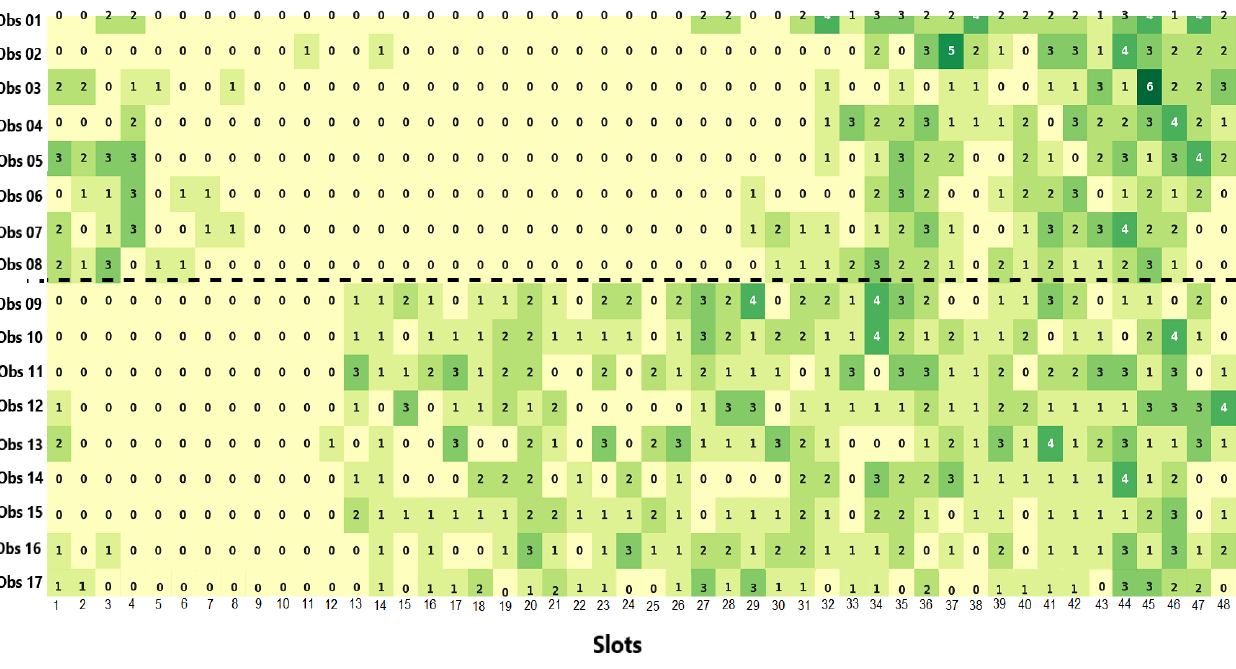
Figure 16. Merge of the social routines of the users u27 and u04